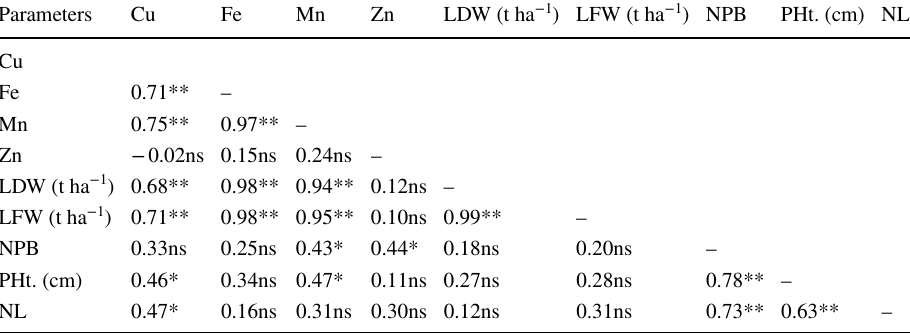
between yield parameters and heavy metal uptake in Corchorus olitorius